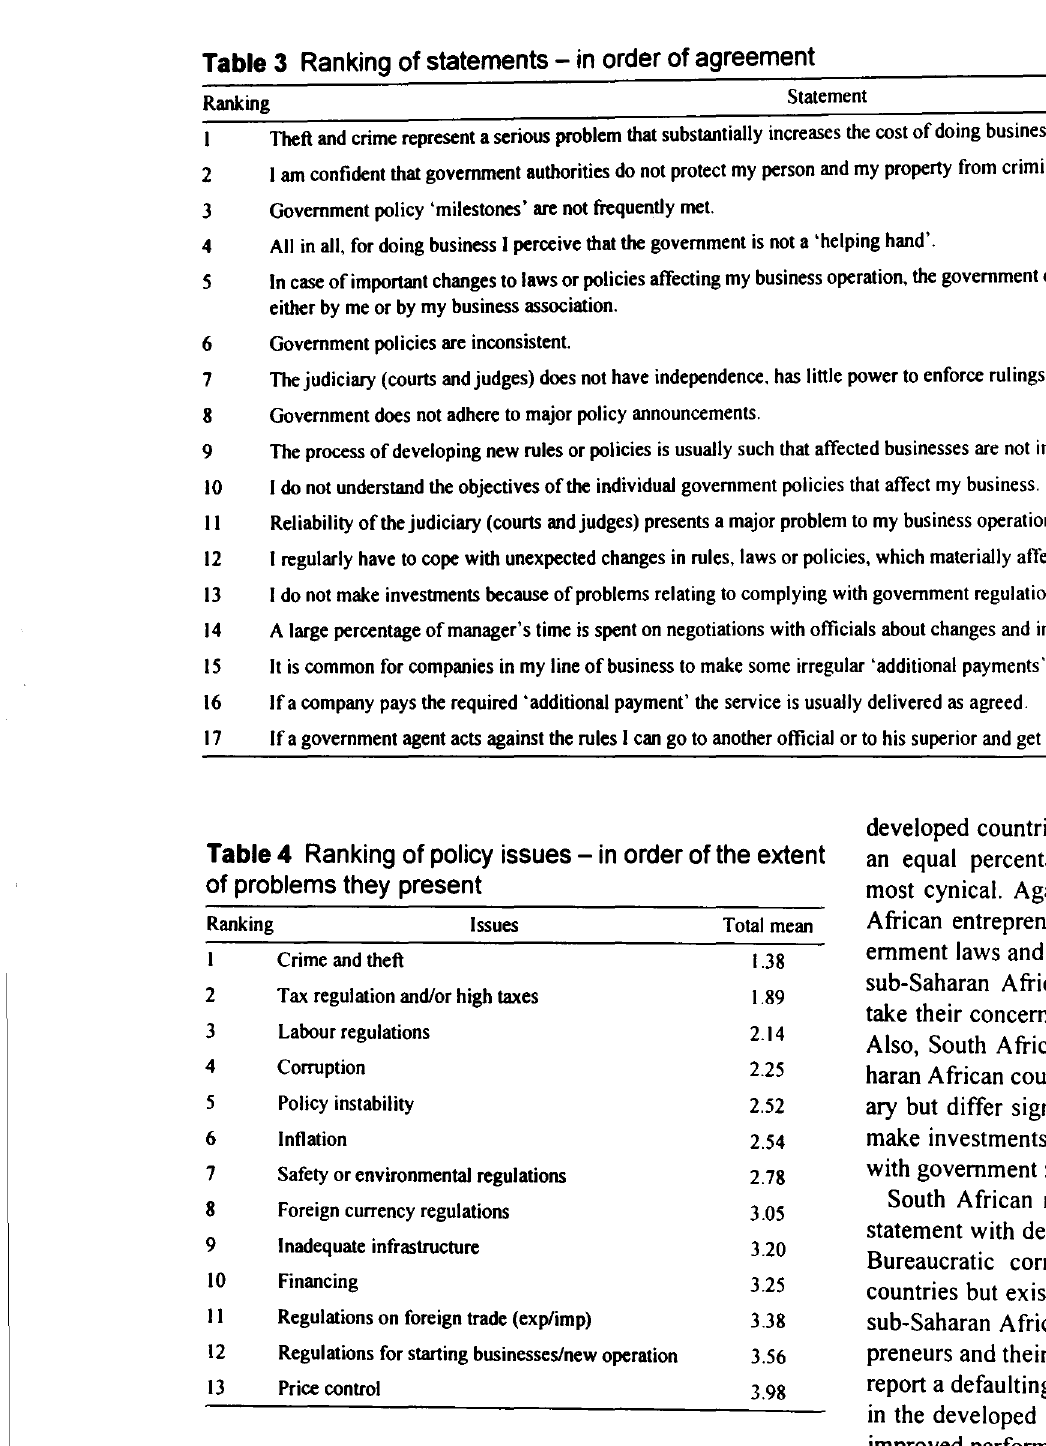
Table 3 Ranking of statements - in order of agreement Ranking